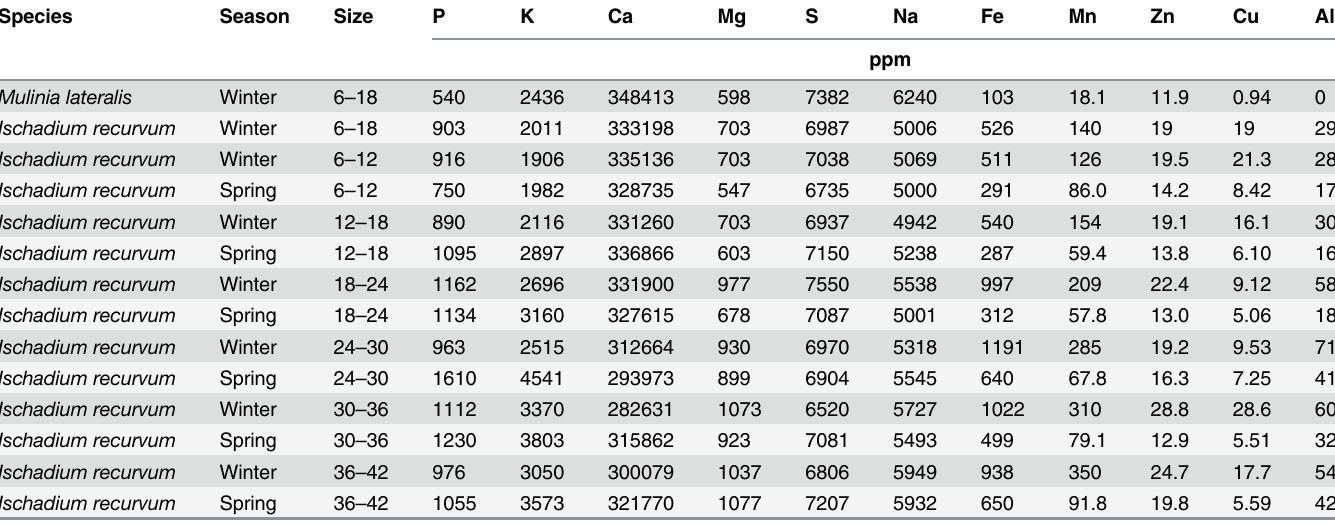
Table 3. The mineral content (ppm) determined for 6 – 18 mm Ischadium recurvum and Mulinia lateralis collected in winter from the Chesapeake Bay and for I . recurvum collected from the Bay in winter and spring by size class (6 – 12, 12 – 18, 18 – 24, 24 – 30, 30 – 36, 36 – 42 mm.)